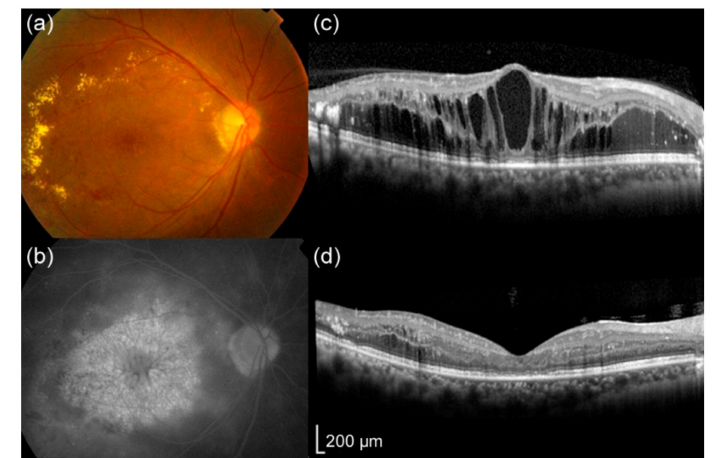
Figure 6. A patient whose eye had a high area ratio and a large number of intraretinal cystoid spaces at baseline who showed thin central retinal thickness (CRT) at the time of cystoid space resolution. This was a 41-year-old man with diabetic macular edema and a best-corrected visual acuity (BCVA) of 0.699 in LogMAR at baseline. A fundus color photograph ( a ), fluorescein angiogram at the